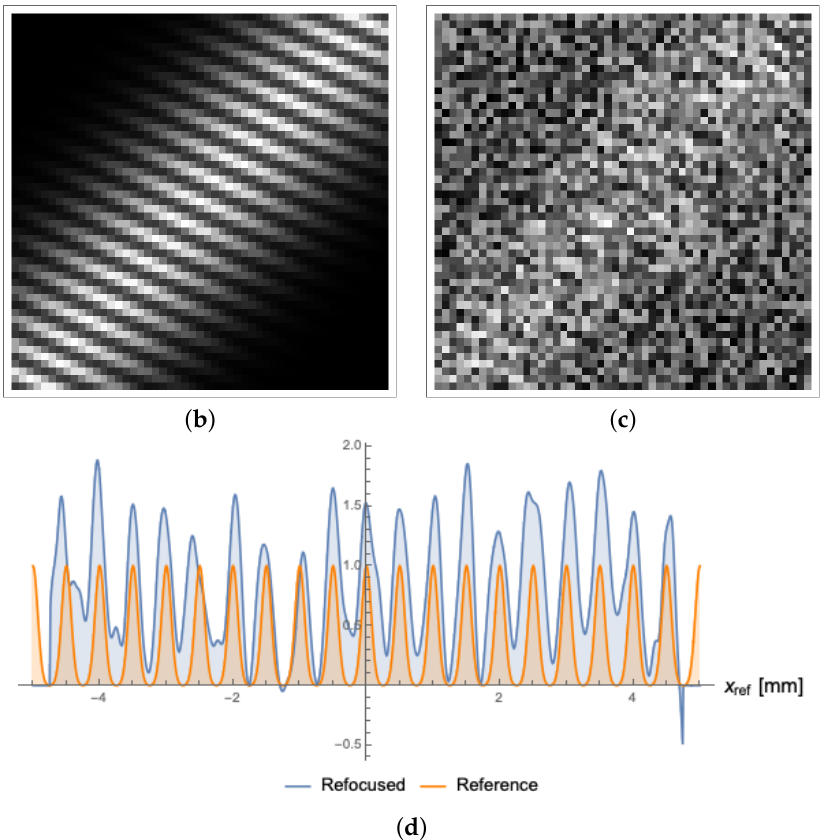
Figure 5. Analysis of the effect of pixelization on the correlation function. Pixel size was taken to be 200 µ m. ( a ) Resolution curve due to pixelization. When the object was placed between the two planes at focus, the resolution defined by the pixel size was given by the linear interpolation between − 1 ) . If the object was placed outside of the two planes, the required ) and ( z the points ( z a , M − 1 b , M B A pixel size needed to discriminate that close details rapidly decrease. ( b ) Effect of pixelization on the correlation function when the object was placed out of focus (at z = 195 mm from the lens); the pixel size (200 µ m) corresponds to 50 pixels per detector. ( c ) Typical aspect of a measured correlation function: zero-average white noise has been superimposed on the normalized theoretical correlation function, so as to simulate a correlation function with a signal-to-noise ratio, which was, at best, 0.5 (standard deviation of white noise amounts to 2 arbitrary units). ( d ) Refocused image obtained from the correlation function reported in panel ( c ) (blue line) , as compared with the reference object (orange line). The refocused image was obtained by applying the refocusing algorithm in Equation (6) and dividing by the correction coefficient in Equation